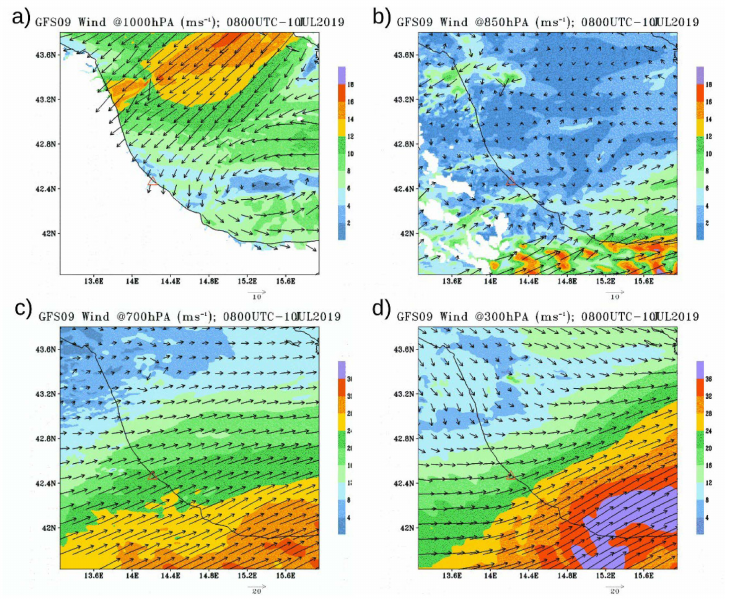
Figure 8. Run GFS09 at 08:00 UTC, 10 July 2019. Wind at 1000 hPa ( a ), 850 hPa ( b ), 700 hPa ( c ), and 300 hPa ( d